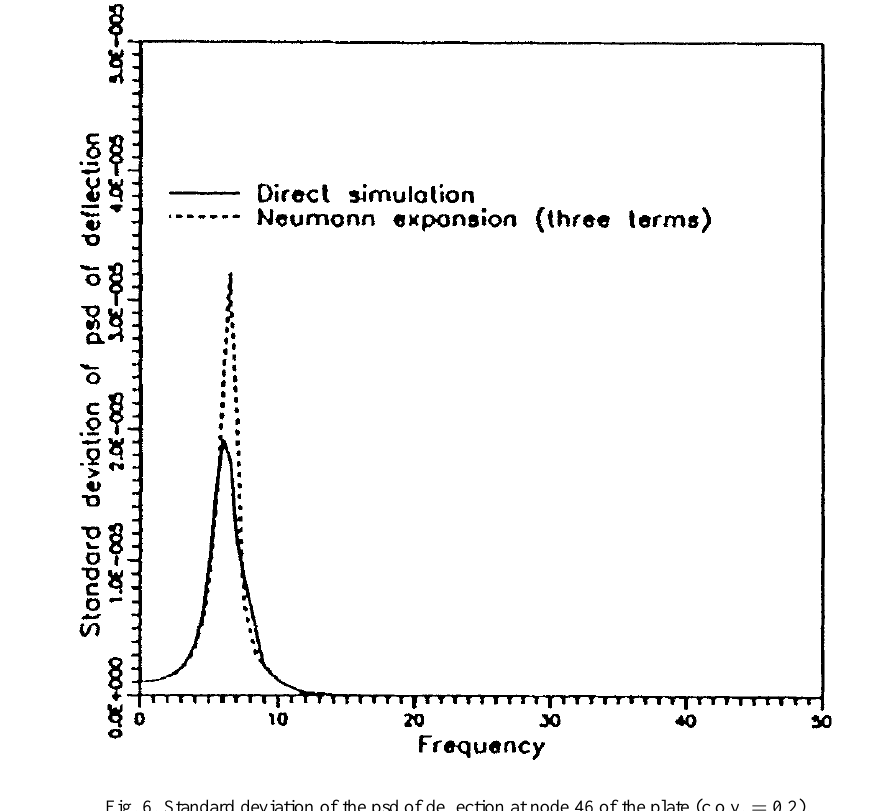
Fig. 6. Standard deviation of the psd of deflection at node 46 of the plate (c.o.v. =